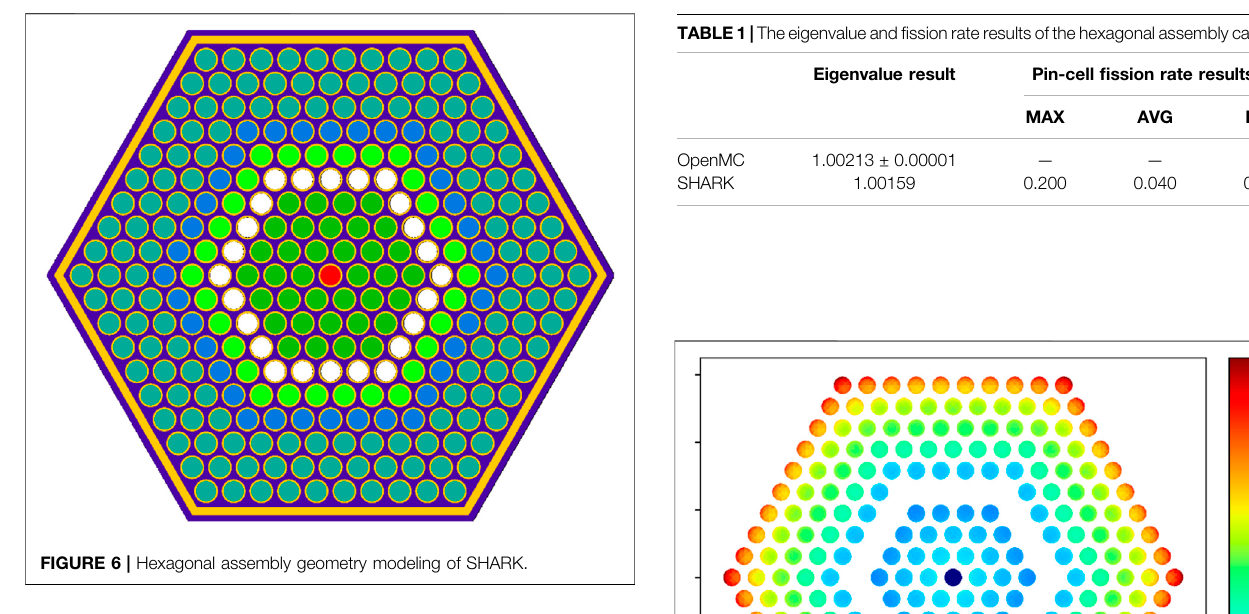
Figure 6 . Ten rings are arranged, including three MOX-8.7% rings, MOX-7% ring, MOX-4.3% ring, control rod ring, 3 UO 2 fuel rings, and fi ssion chamber from outside to inside. The assembly box can be explicitly modeled. The pitch of the hexagonal pin cell is 0.91 cm. Radiuses of the inner and outer fuel pellets are 0.33 and 0.39 cm. Thicknesses of the assembly box and assembly gap are 0.26 and 0.22 cm separately. The multi- group cross-sections are from the C5G7 benchmark (OECD, 2005).